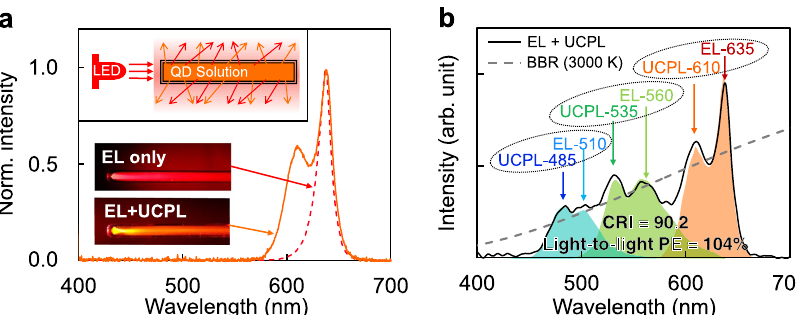
Fig. 6 Application of QD-UCPL on lighting. a Photographs and spectra of electroluminescence (EL) from a plain light-emitting diode (LED) (red dashed line) and EL + UCPL from a QD-based hybrid light source (orange solid line). Inset: schematic diagram for the hybrid light source. b